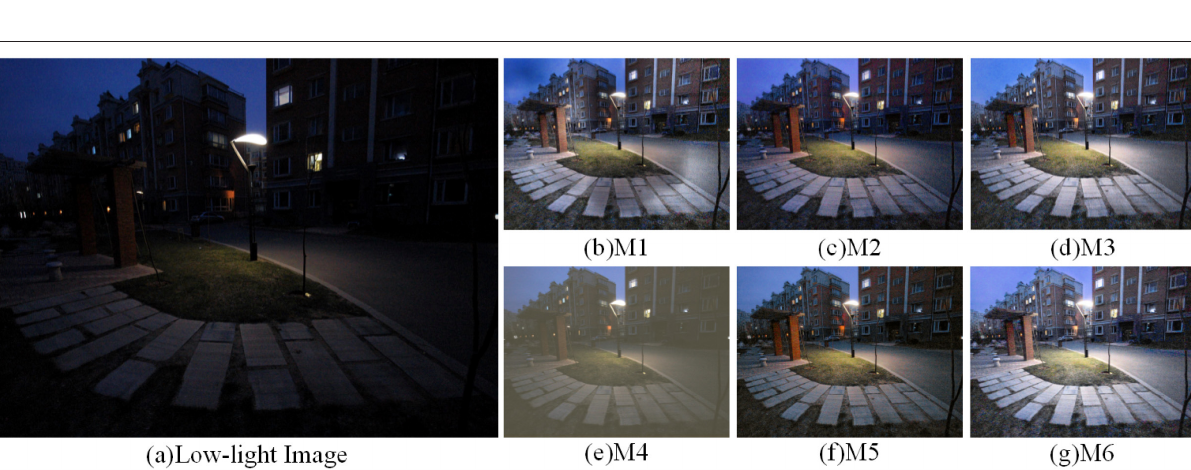
FIGURE 13 | Visual comparison results with different combinations of modules in the DICM dataset. (A) shows the low light image and (B–G) show the effect of the enhanced low light image with different combinations of modules.